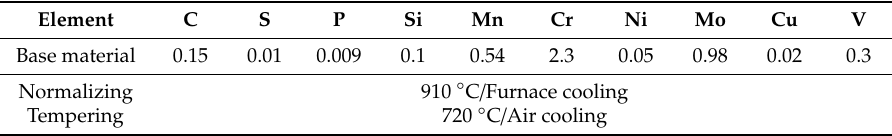
Table 1. Chemical composition (wt.%) and heat treatment